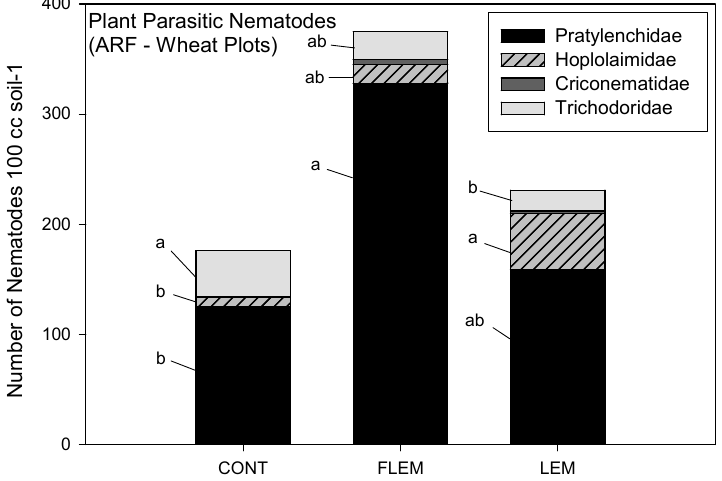
Figure 3. Comparison of plant parasitic nematode families sampled in the annual ryegrass/fallow rotation system (ARF) during the winter (wheat season). Different letters indicate differences between treatments. No letters indicate no significant differences between treatments; α = 0.1.